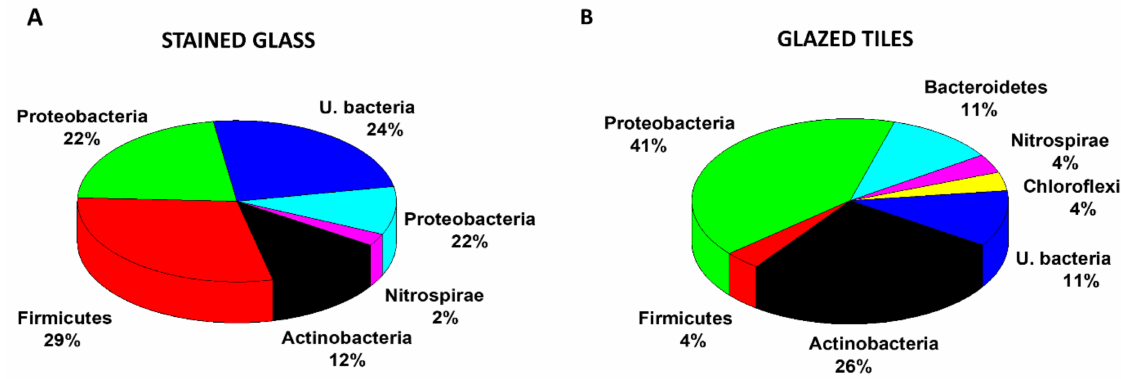
Figure 4. Relative % of Bacteria Phyla of stained glass and glazed tiles, reported in the literature for the 21st century. The category “U. Bacteria” are unidentified bacteria. ( A ) Stained glass. ( B ) Glazed tiles.